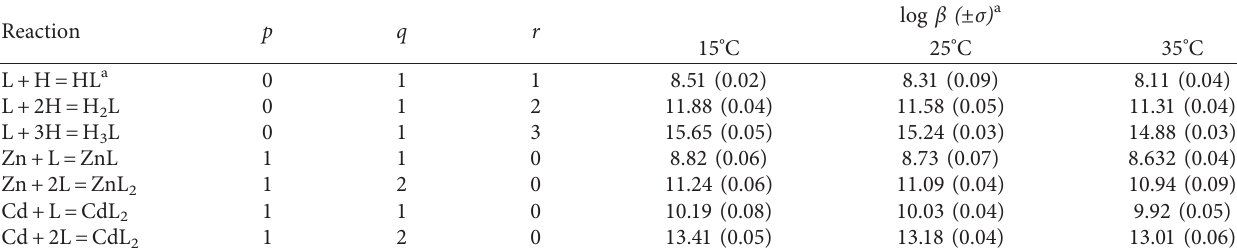
Table 7: Stepwise stability for the complexes of DMPTHP with Zn(II) and Cd(II) metal ions in 50% DMSO-H